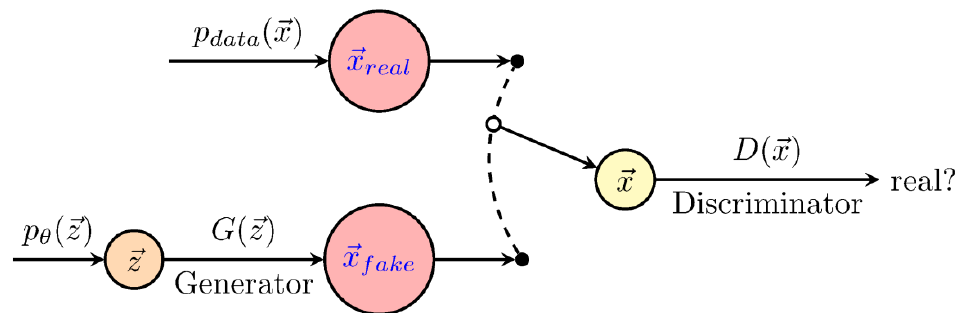
Figure 4. Scheme of generative adversarial networks (GANs). The generator (G), defines a probability distribution based on the information from the samples, whereas, the discriminator (D) distinguishes data produced by G from the real data. The figure was redrawn using code from http://www.texample.net/tikz/examples/neural-network.